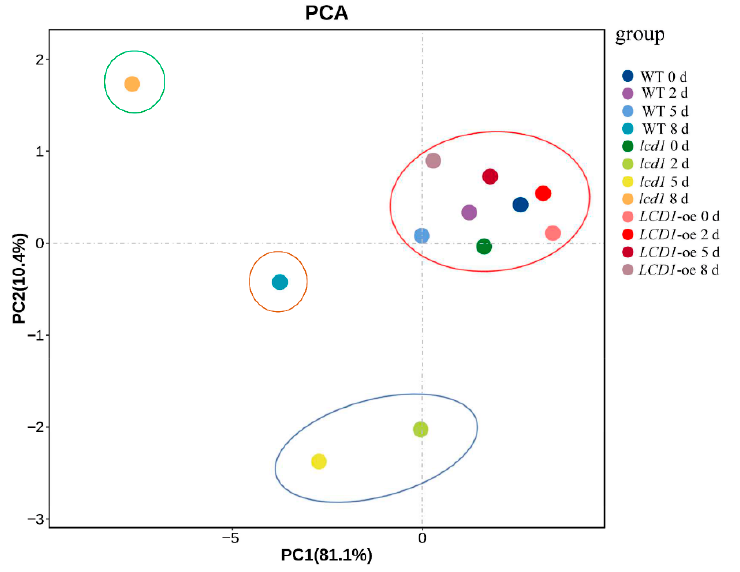
Figure 8. Principal component analysis based on the parameters of chlorophyll, chlorophyll a, chlo- rophyll b, chlorophyll a/b, H 2 O 2 , malondialdehyde (MDA), and gene expressions of NYC1 , PAO